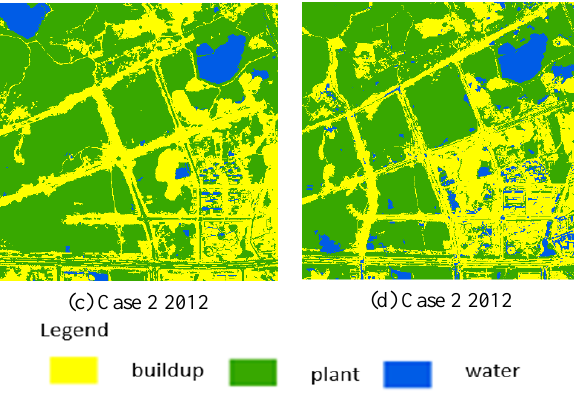
Figure 4 Classification Results of Single-scale CART Tree